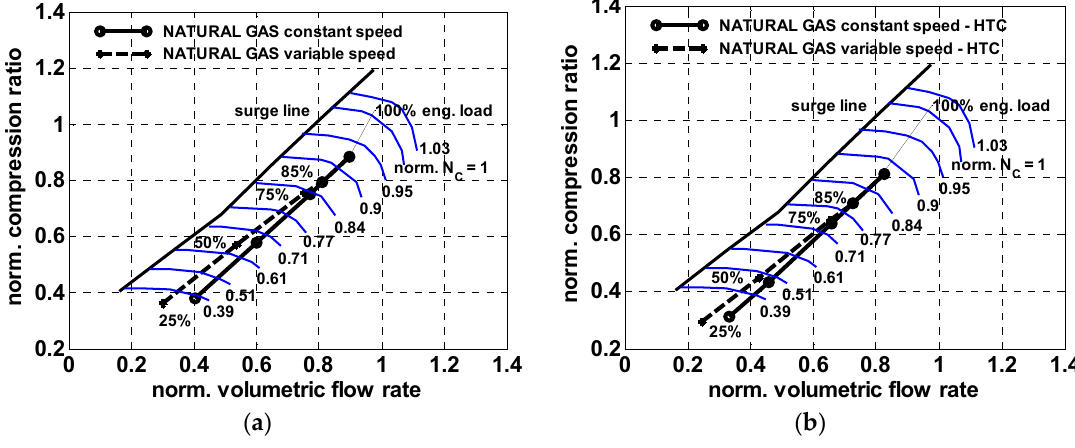
Figure 6. Compressor maps of the NG engine with original ( a ) turbocharger and hybrid ( b ) turbocharger: calculated working points for different engine loads, at both constant and variable engine speed.